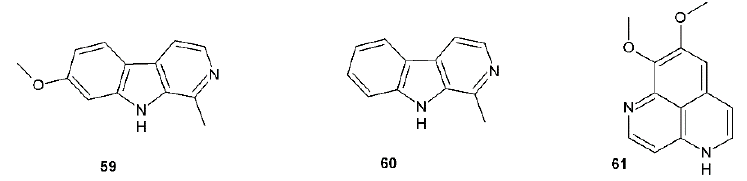
Figure 3. Alkaloids with antiherpetic activity.